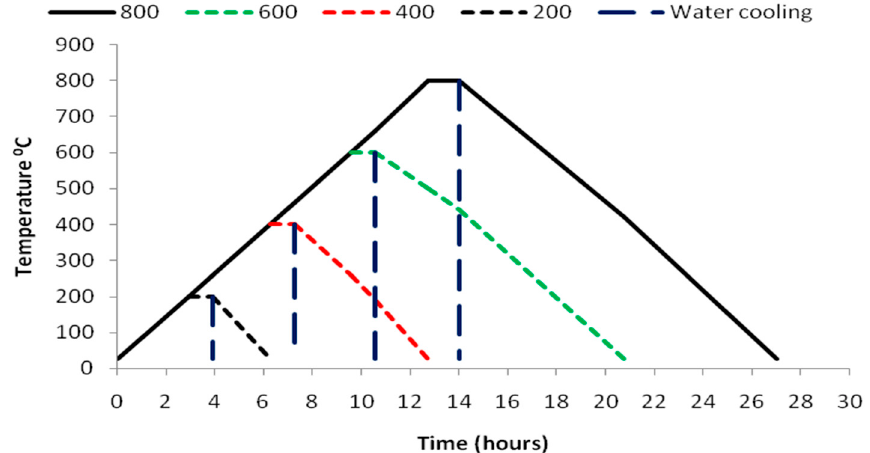
Figure 5. Heating and cooling regimes for Air and water cooling.